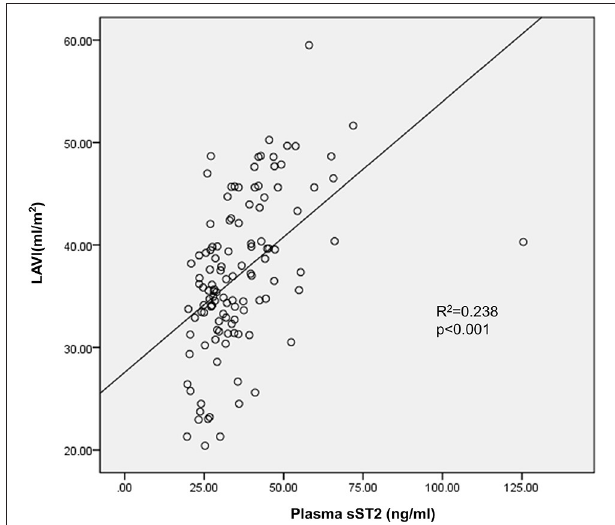
FIGURE 2 | Baseline level of circulating sST2 linked to left atrial volume index (LAVI) in persistent AF patients. Multivariate linear regression analyzed the correlation between baseline sST2 and